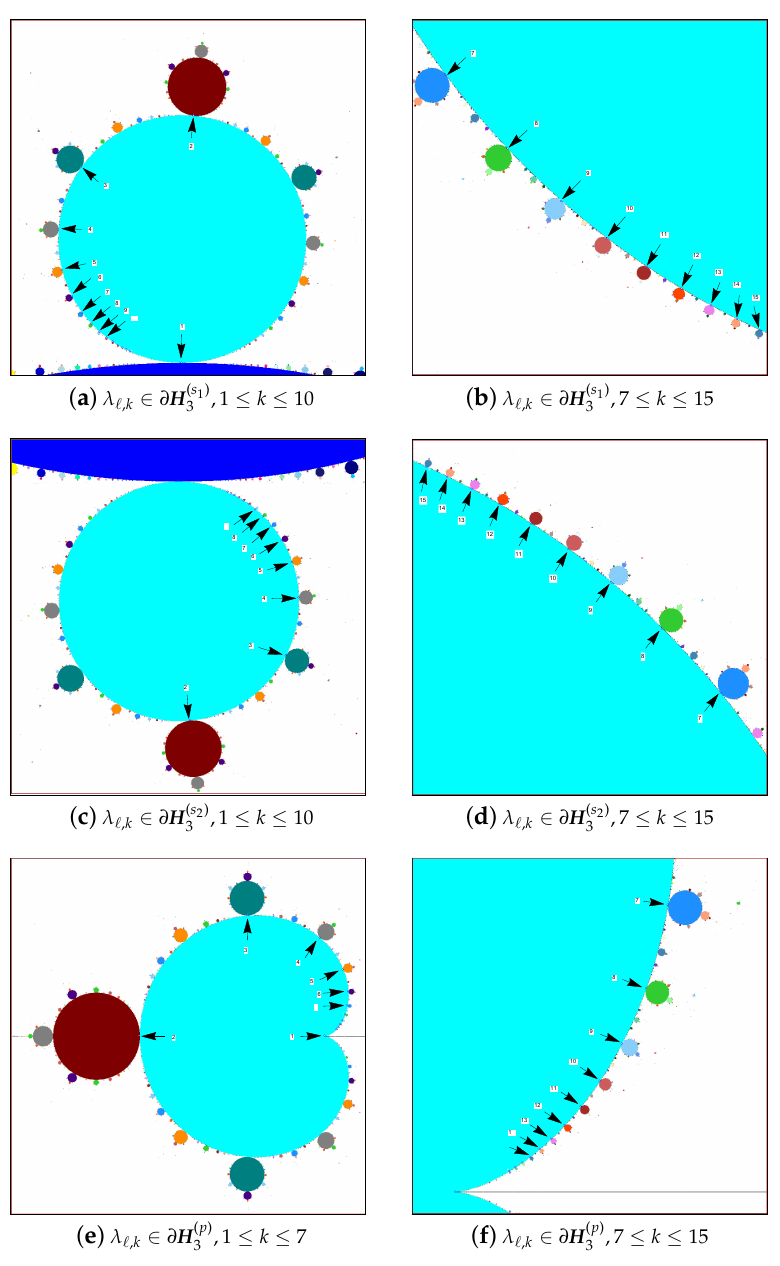
Figure 8. Bifurcation points λ (cid:96) , k occurring on ∂ H 3